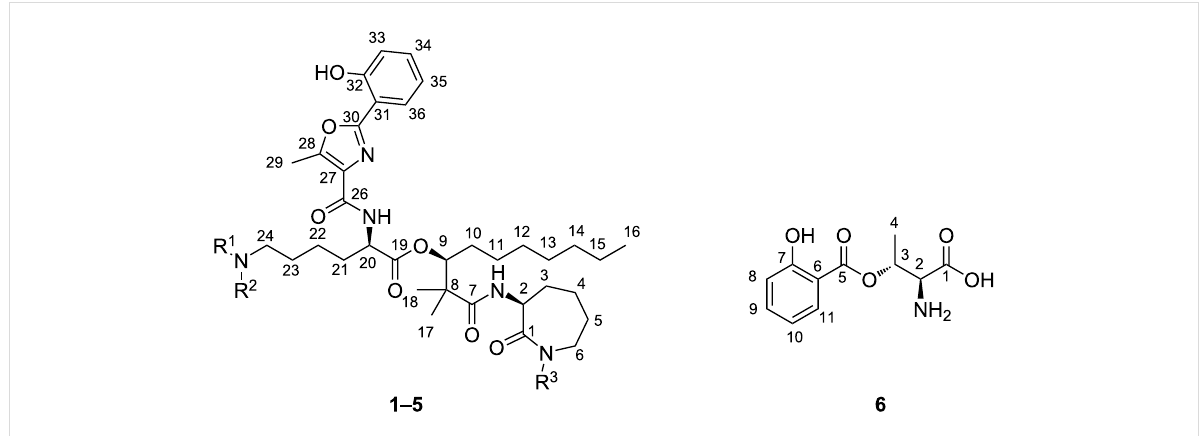
Figure 1: Chemical structures of amamistatins ( 1 – 5 ) and a putative biosynthetic shunt product ( 6 ) isolated in this study. 1 : R 1 = CHO, R 2 = H, R 3 = H; 2 : R 1 = CHO, R 2 = H, R 3 = OH; 3 : R 1 = H, R 2 = H, R 3 = H; 4 : R 1 = H, R 2 = OH, R 3 = H; 5 : R 1 = CHO, R 2 = OH, R 3 =